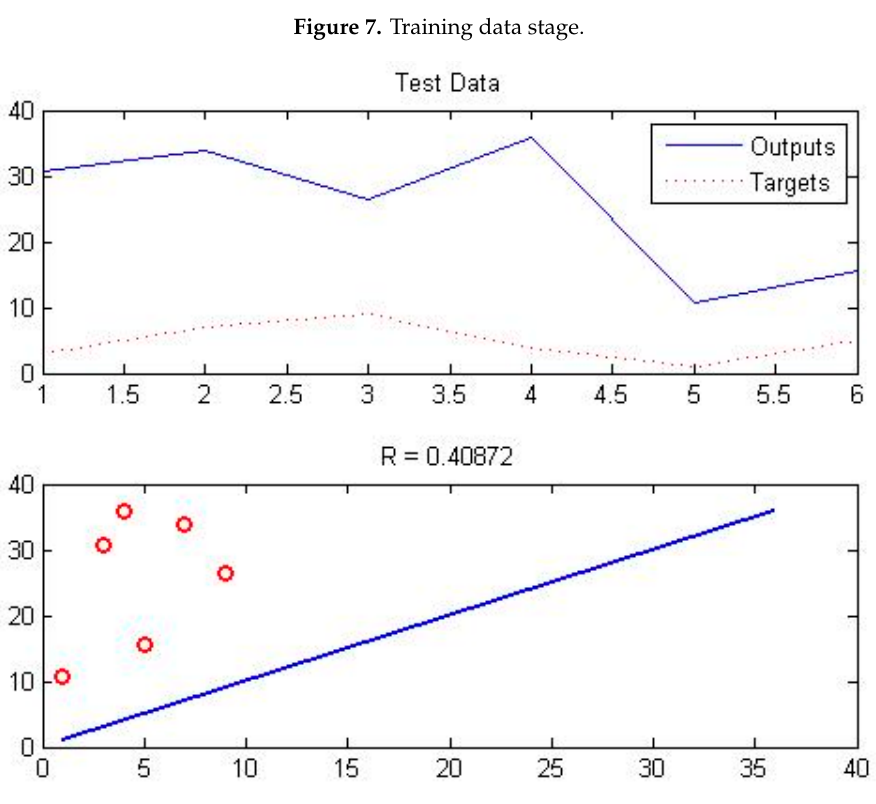
Figure 8. Testing data